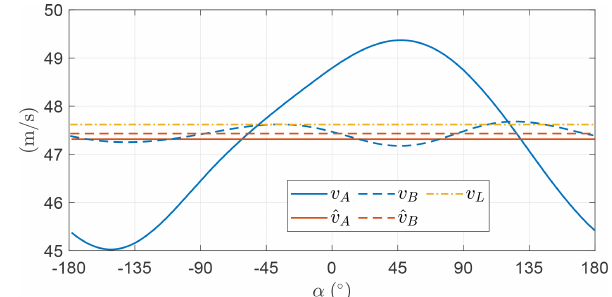
Figure 11. Norm of the optimal AWES velocity v as a function of the angular position.